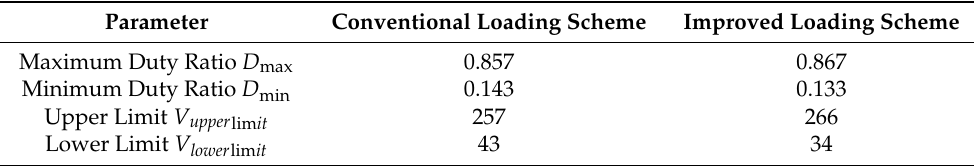
Table 3. Comparison of the parameters between the conventional and improved loading